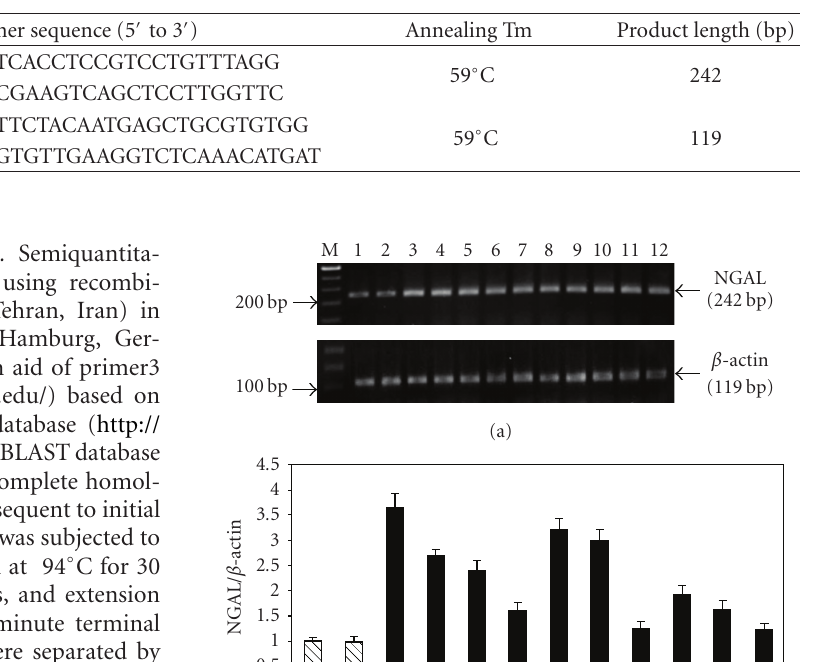
Table 2: Sequence and characteristics of PCR Primers.